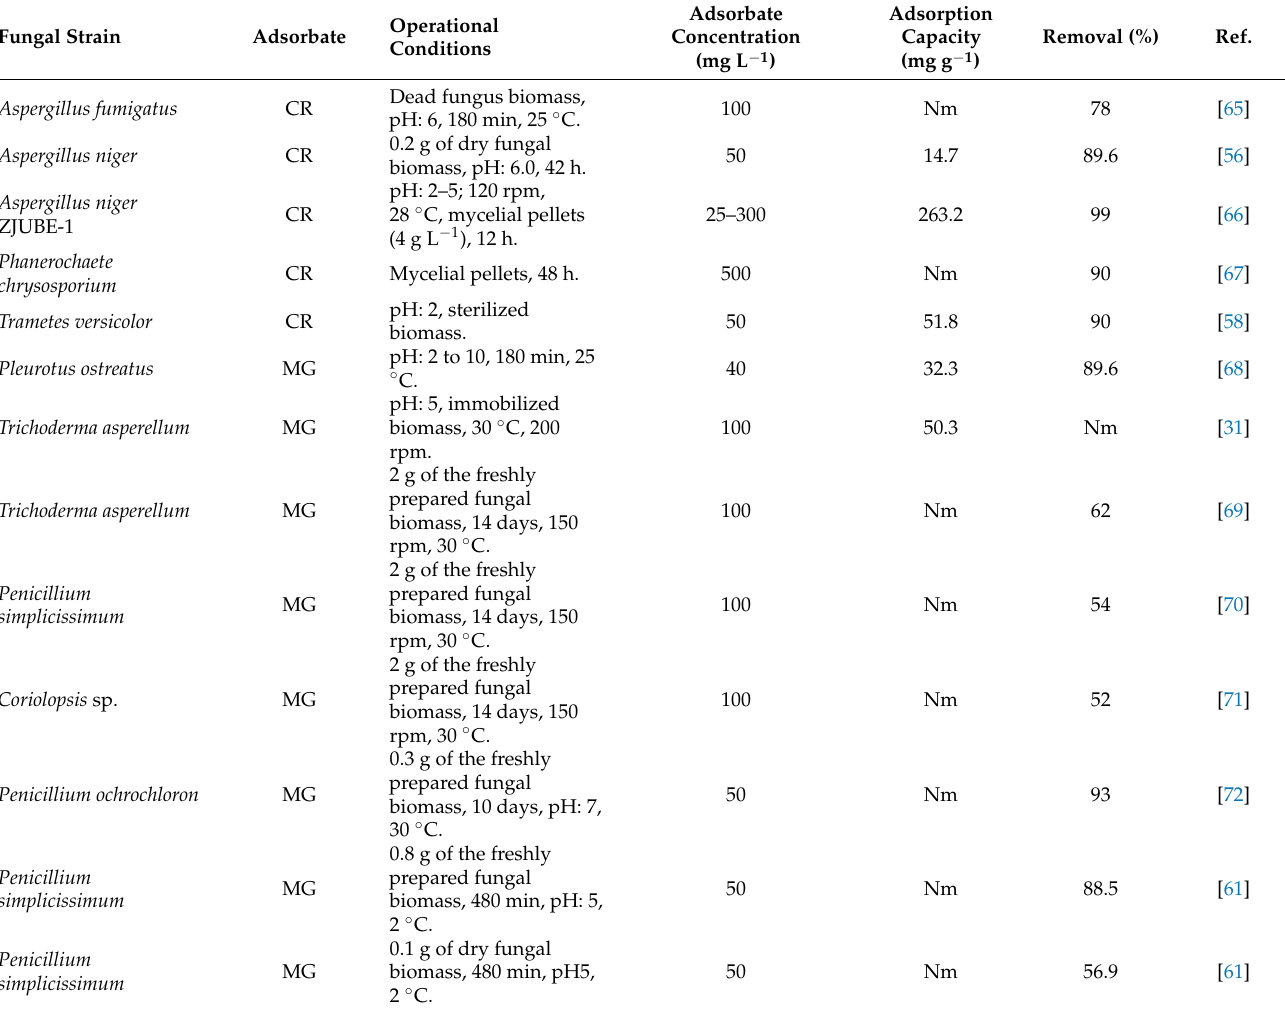
Table 1. Fungal biomass used for removal of Congo red and malachite green.